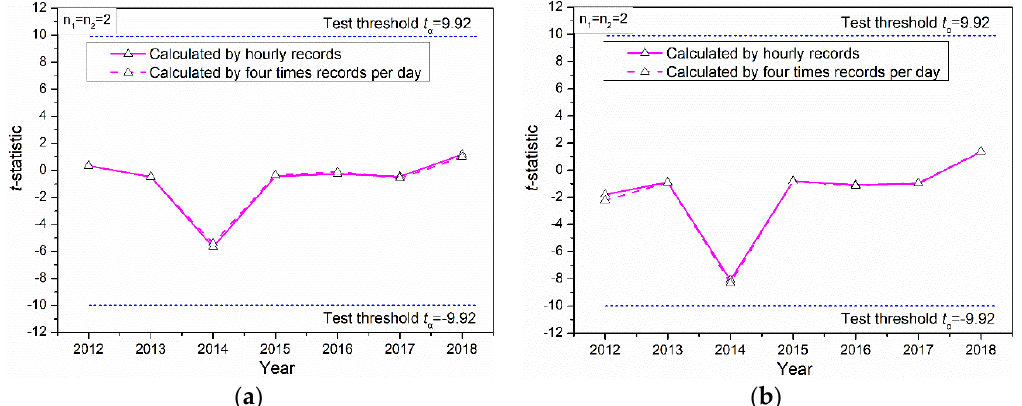
Figure 2. The impact of the quality of meteorological records on the analysis results of abrupt climate changes (ACC) (Beijing). ( a ) The abrupt change points based on annual average data; ( b ) the abrupt change points based on monthly average data.